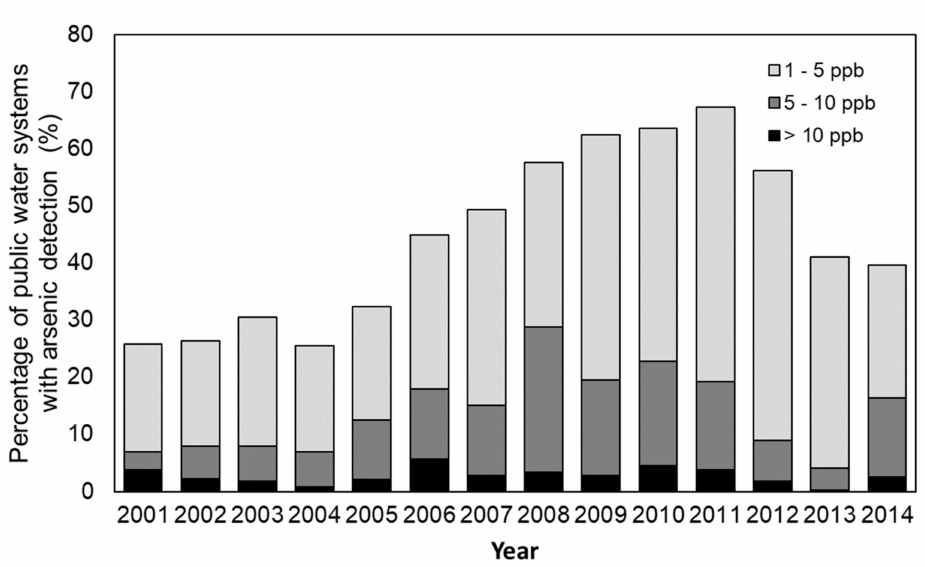
Figure 3. Percentage of public water systems by annual median arsenic category, 2001–2014.